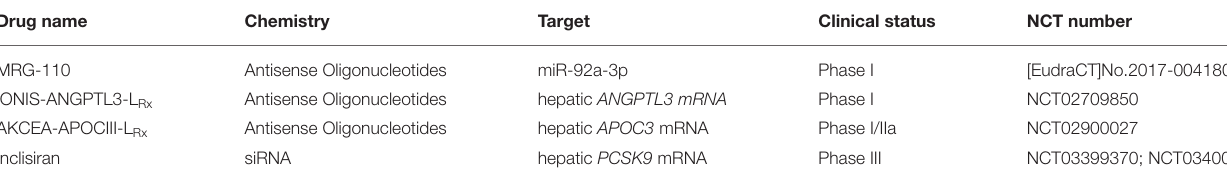
TABLE 2 | RNA therapeutics in